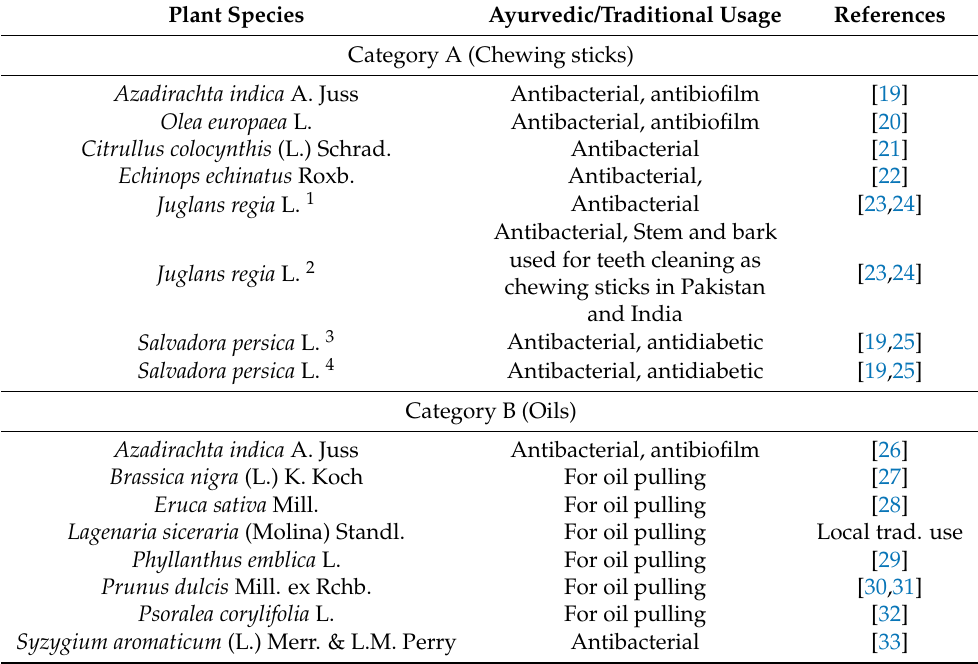
Table 1. Traditional uses of selected Ayurvedic medicinal